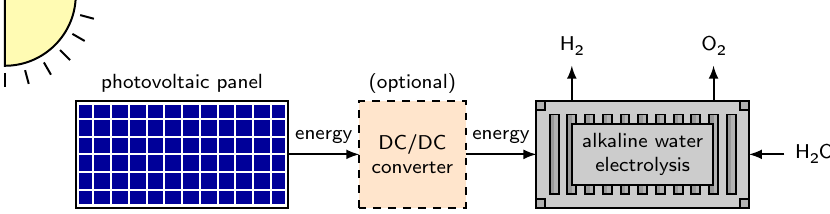
Figure 8. Schematic of alkaline water electrolysis powered by solar energy. Photovoltaic panels